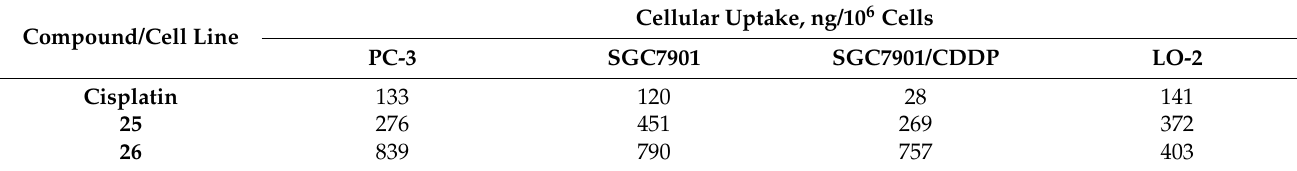
Table 14. Cellular uptake in PC-3 (prostate carcinoma), SGC7901 (gastric cancer), SGC7901/CDDP (cisplatin-resistant gastric cancer), and LO-2 (normal liver) cell lines preincubated with prodrugs 25 , 26 , and cisplatin after 12 hours of incubation (ng/10 6